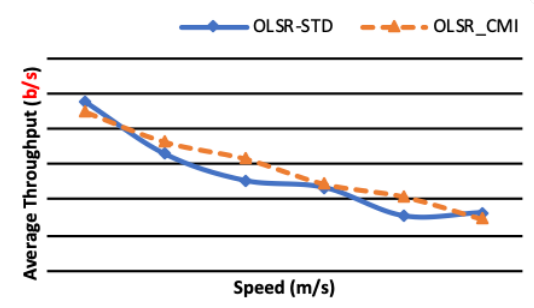
Fig. 6. Throughput depending on the nodes speed (m/s)